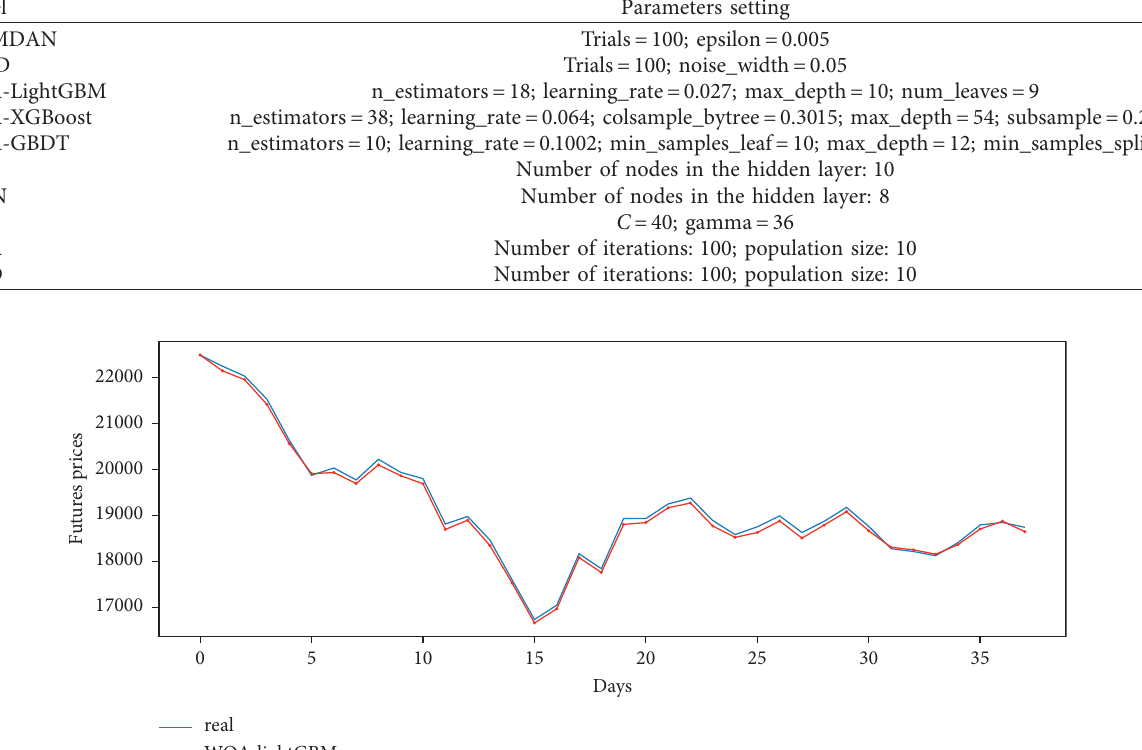
Table 5: Parameters setting.